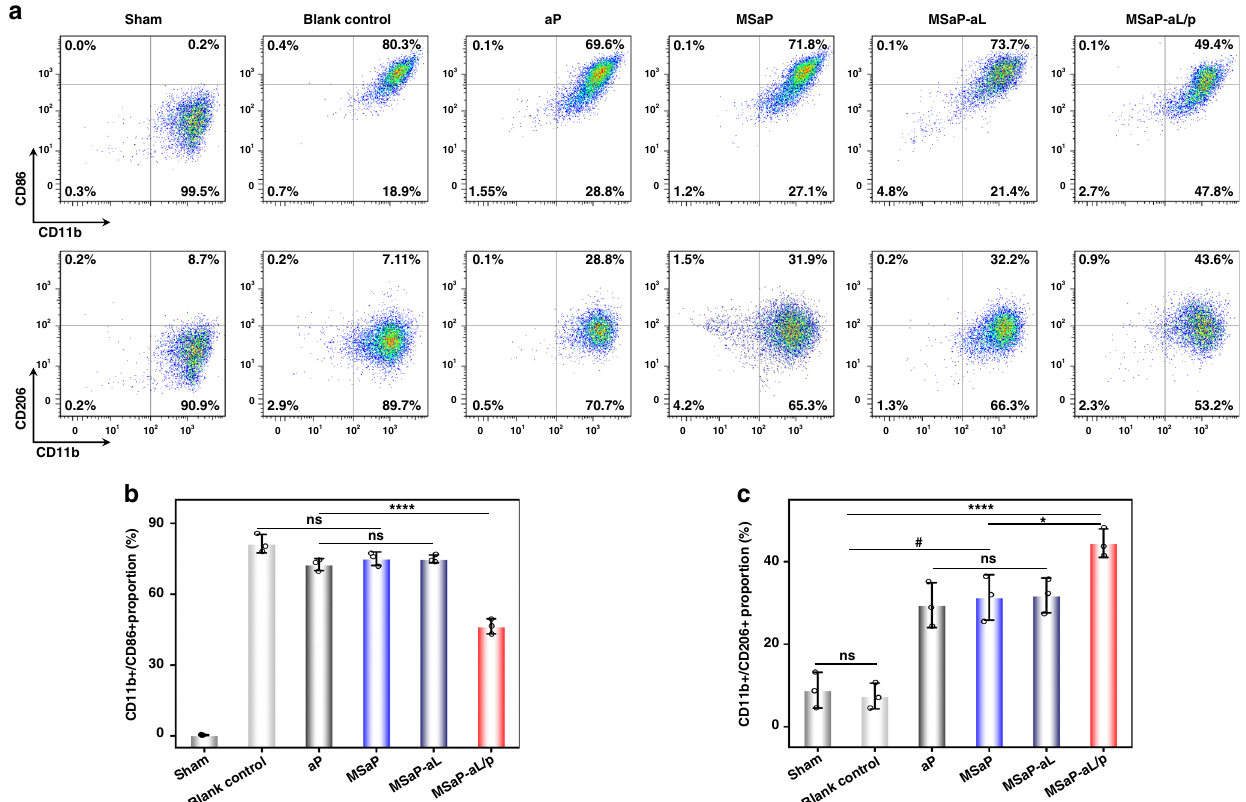
Fig. 9 Phenotypic identi fi cation of immune cells in vivo. a Flow cytometric analysis (3 independent experiments) of CD11b/CD86-positive cells with b its quanti fi cation analyzed of the ratio and CD11b/CD206-positive cells with c its quanti fi cation analyzed of the ratio ( n = 3, all values were mean ± std. dev., # p < 0.001 when comparing non-immunoregulatory fi ber groups and blank control group and * p < 0.05, **** p < 0.0001 when comparing MSaP-aL/p and other control groups via one-way analysis of variance (ANOVA) with Tukey ’ s post hoc test, ns not signi fi